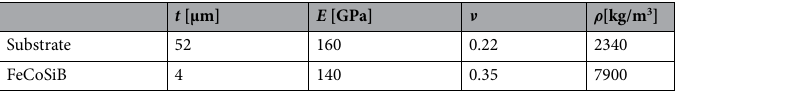
Table 2. Model parameters. Layer thicknesses t , Young’s modulus E , Poisson’s ratio ν and density ρ used in the finite element